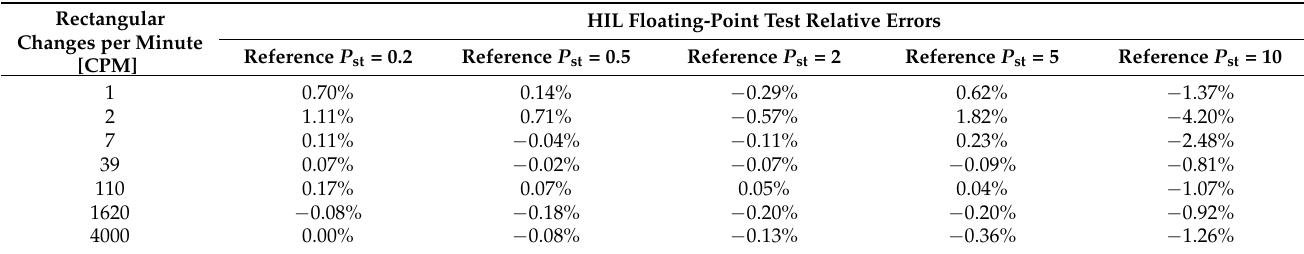
Table 8. Response to rectangular voltage fluctuations—floating-point tests.